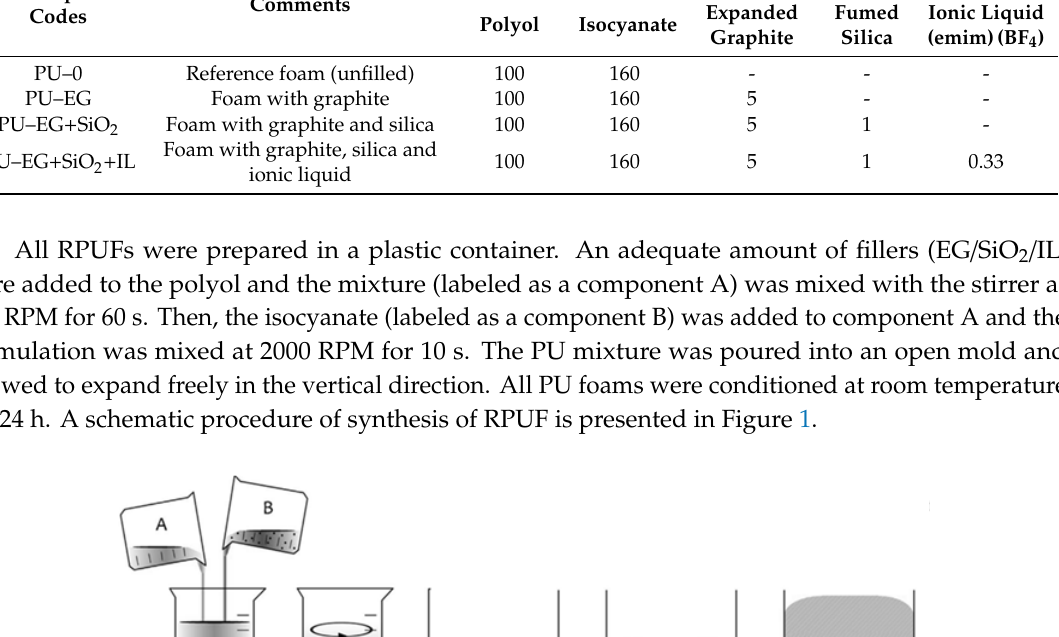
Table 1. Formulations of rigid polyurethane foams (RPUF) prepared in the study.